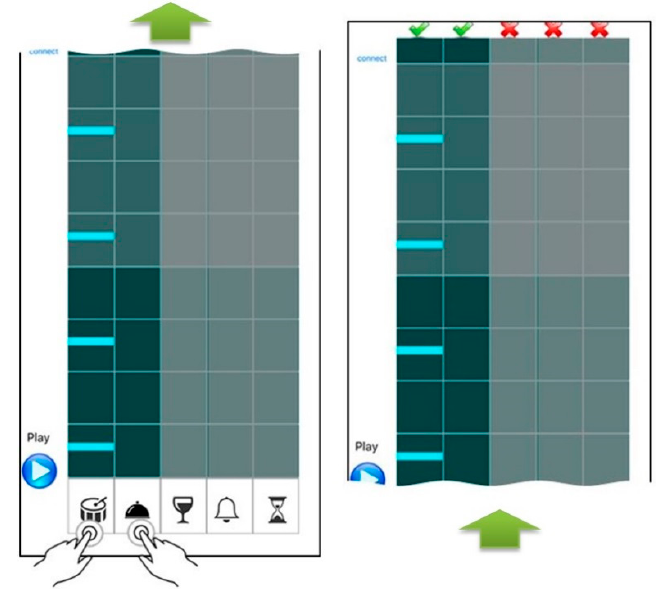
Figure 10. Test musical score in the experiment. Table 2. Testing results of 10 students.